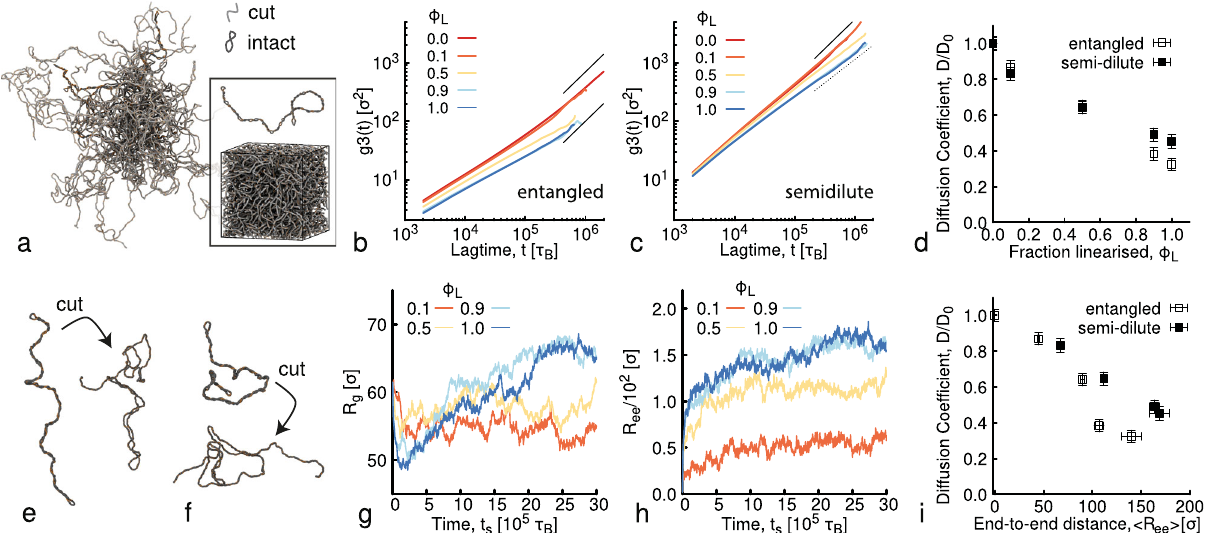
fl uids, showing a monotonic slowing down with increasing linearised fraction ϕ L . HigherDNA concentration results in a stronger decrease in mobility with increasing ϕ L , similar to experiments. e , f Snapshot of simulated chains before and after being cut, showing examples of long-lived coiled conformations in entangled ( e ) and semidilute ( f ) conditions. Notice that chains display an initial reduction in con- formational size followed by an expansion as the polymer relaxes to steady-state. (cid:1) (cid:3) = 2 2 i 1 = 2 and h end-to-end dis- g Radius of gyration R g = h R 2 g i 1 = h 1 = N ∑ N i r i (cid:2) r CM (cid:3) 2 i 1 = 2 averaged over all (cut and intact) rings in the system. i Diffusion coef fi cients D / D 0 plotted against average end-to-end distance R ee measured atlarge simulationtimesshowing adirect correlation betweenslower dynamics and larger coil sizes that is stronger for higher DNA concentrations, as seen in